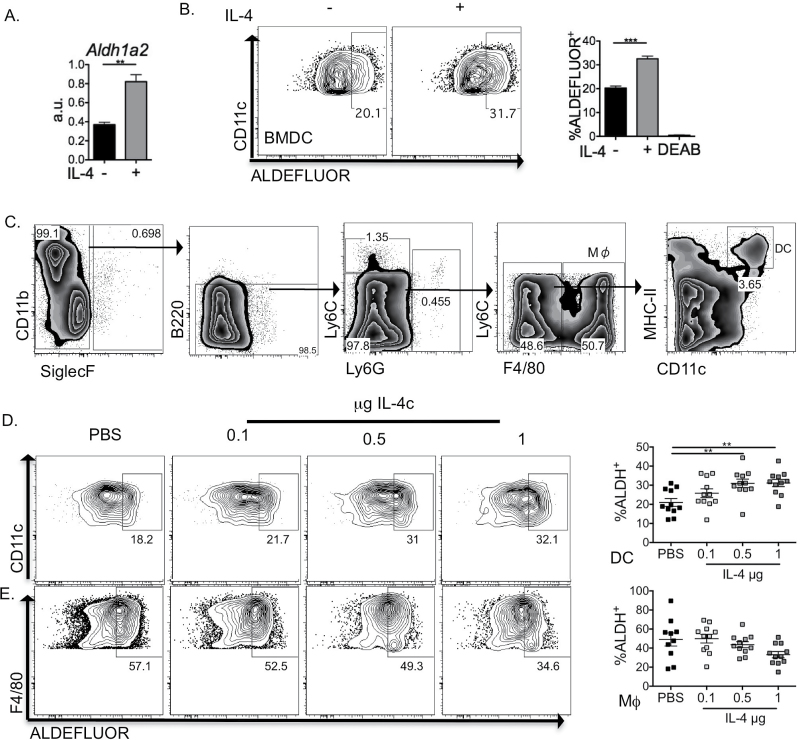
IL-4 induces aldehyde dehydrogenase activity and alternative activation in DCs in vitro and in vivo. BMDCs were cultured overnight with 20-ng ml−1 IL-4 (A and B) and expression of Aldh1a2 (A) and aldehyde dehydrogenase activity (B) assessed. IL-4c (doses as described in figure) was injected intra-peritoneally. Peritoneal exudate cells were harvested 6h later, DCs were defined as SiglecF−B220−Ly6C−Ly6G−F4/80−CD11c+MHCIIhi and macrophages as SiglecF−B220−Ly6C−Ly6G−F4/80+ (C). Aldehyde dehydrogenase activity of DC and macrophage populations was assessed ex vivo (D). Data in A and B are representative of five independent experiments, error bars represent triplicate culture wells. Data points in (D) and (E) represent individual mice, pooled from three independent experiments n = 10–11 per group. **P < 0.01, ***P < 0.001.